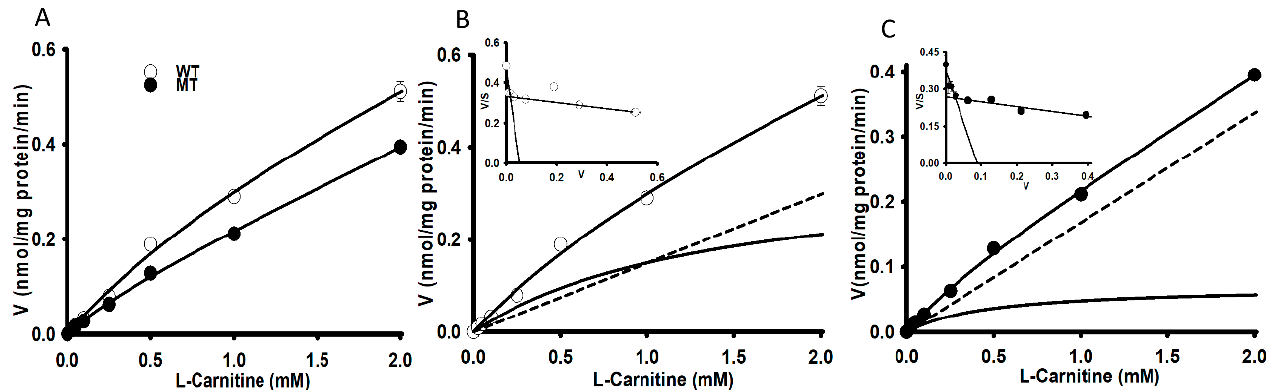
Figure 2. Concentration-dependent uptake of [ 3 H]L-carnitine in NSC-34 cell lines ( A ). [ 3 H]L-Carnitine uptake was carried out using a unlabeled L-carnitine concentration of 0–2 mM in NSC-34 WT ( B ) and MT ( C ) cell lines at 37 °C for 15 min under physiological pH. Each point represents the mean ± S.E.M ( n = 3). Table 1. Kinetic analysis of [ 3 H] L-carnitine uptake by NSC-34 cell lines. Parameters